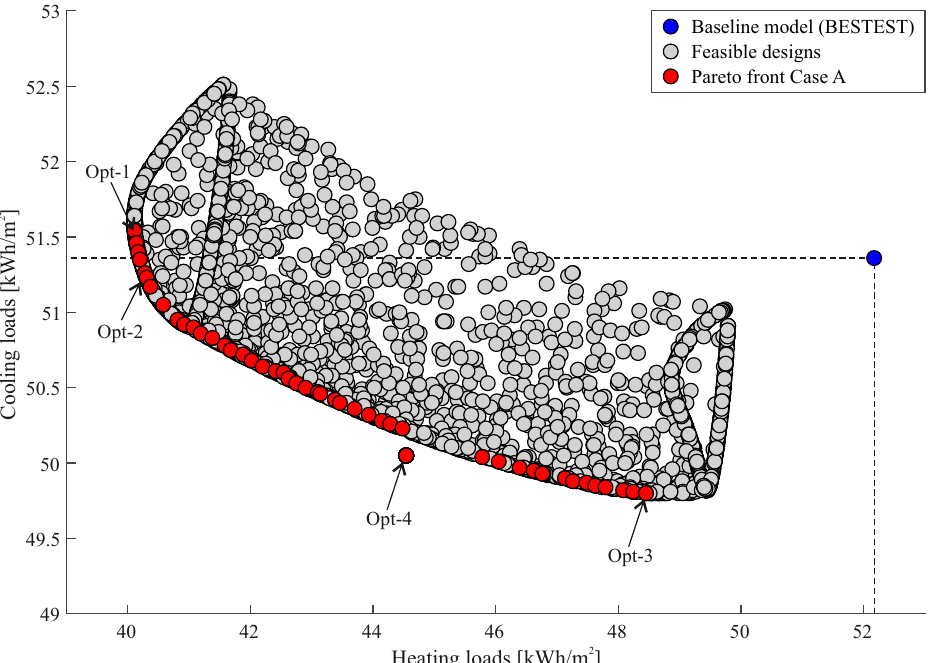
Figure 5. Optimization results of the annual ideal loads for heating and cooling obtained for Case